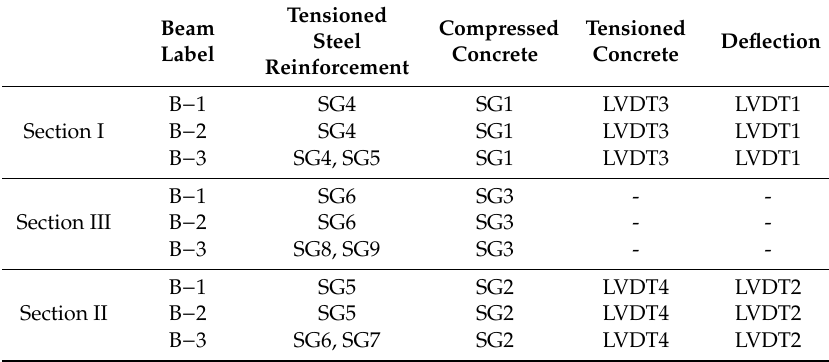
Table 6. Position of strain gauge tapes (SG) and linear variable displacement transducers (LVDT) dilatometers in Sections I, II and III of the tested beams.